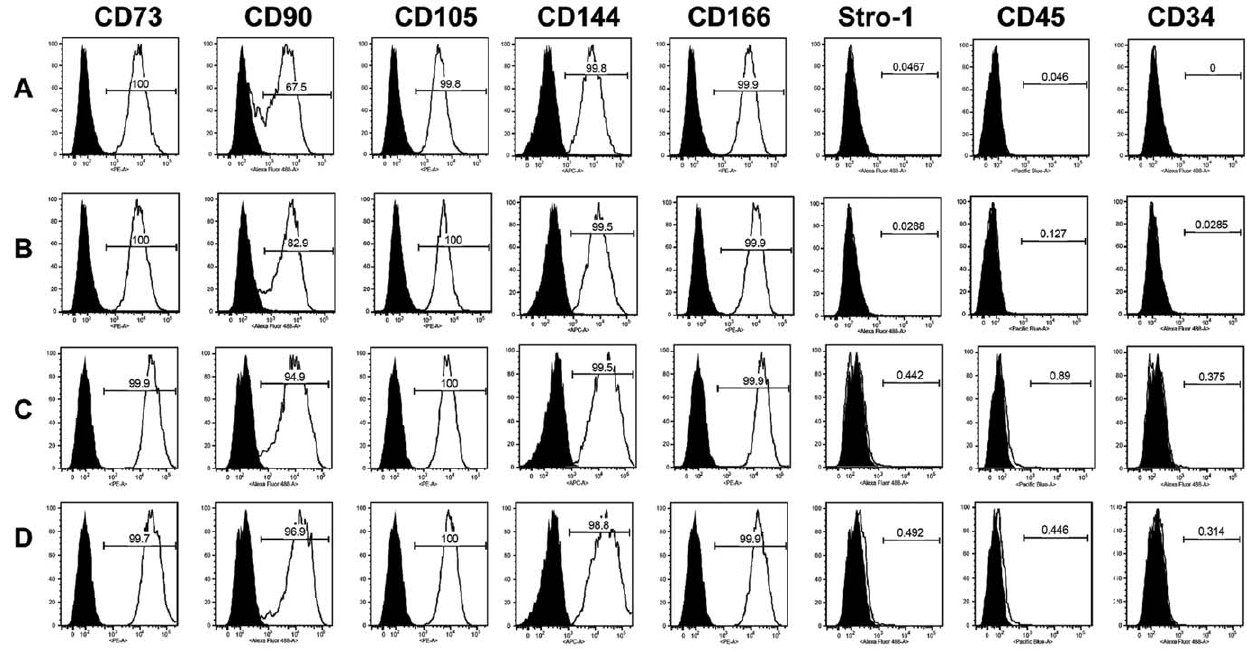
Figure 3. Flow cytometry analysis of surface markers consistent with adult MSCs. Surface antigen profile analysis by flow cytometry for the derived MSC-like cells. (A) and (C) are from cells derived from H9 at passage 2 and 4, respectively. (B) and (D) are from cells derived from YK26-iPSCs at passage 2 and 4, respectively. The black histogram represents the unstained control and white overlay represents each antigen. The numeric values shown within the histograms represent the percentage of the positive cells.